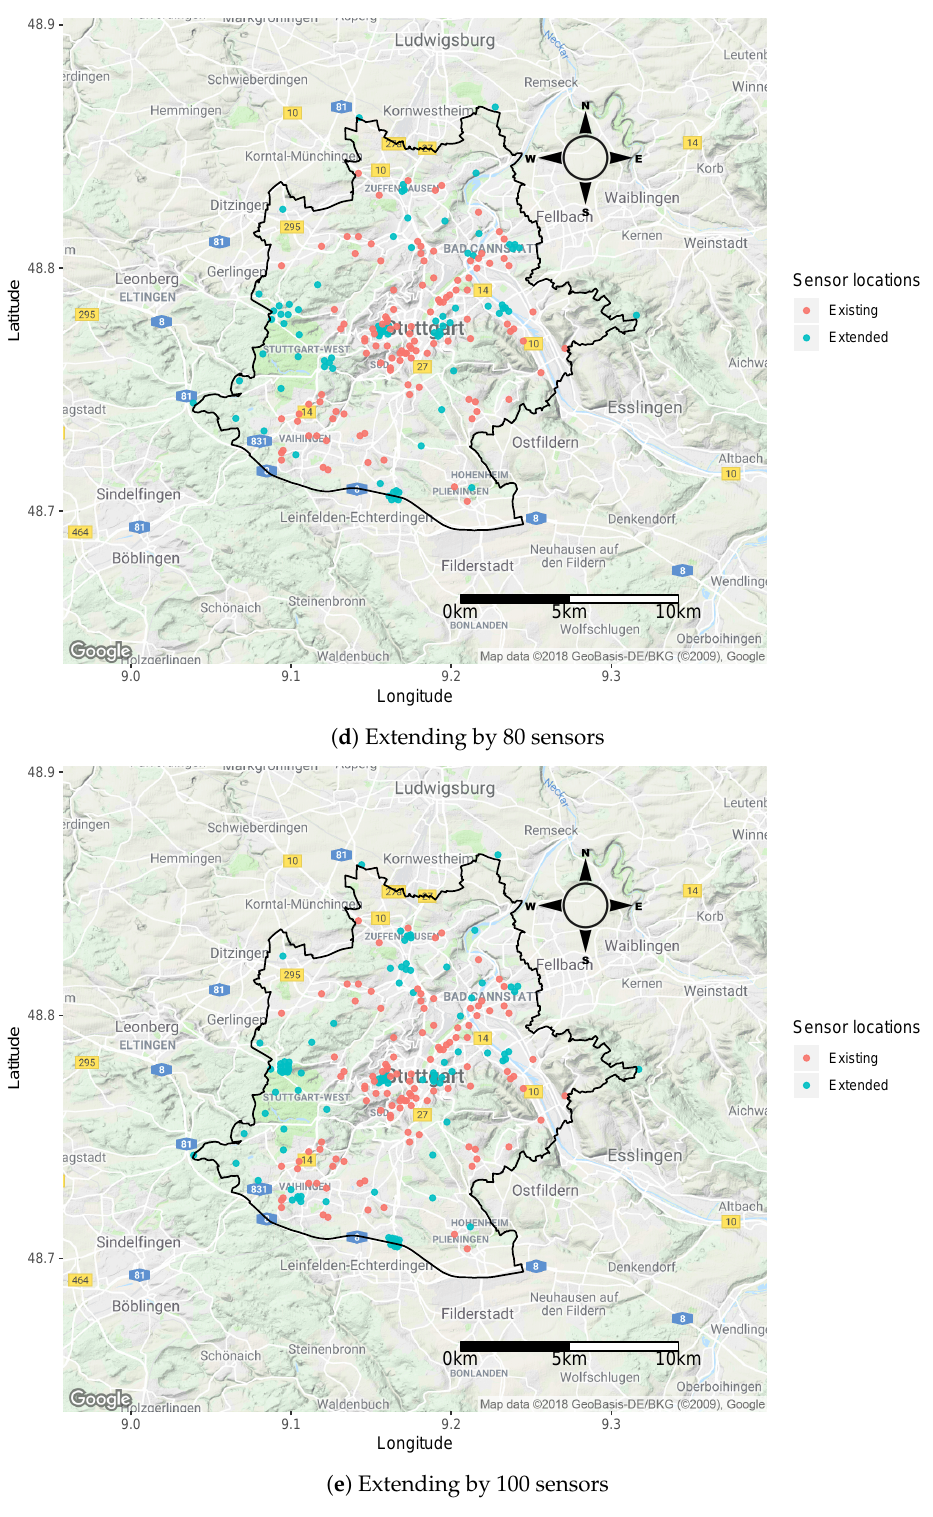
Figure 11. Optimal locations identified for extending the existing crowd sourcing monitoring network using proposed objective